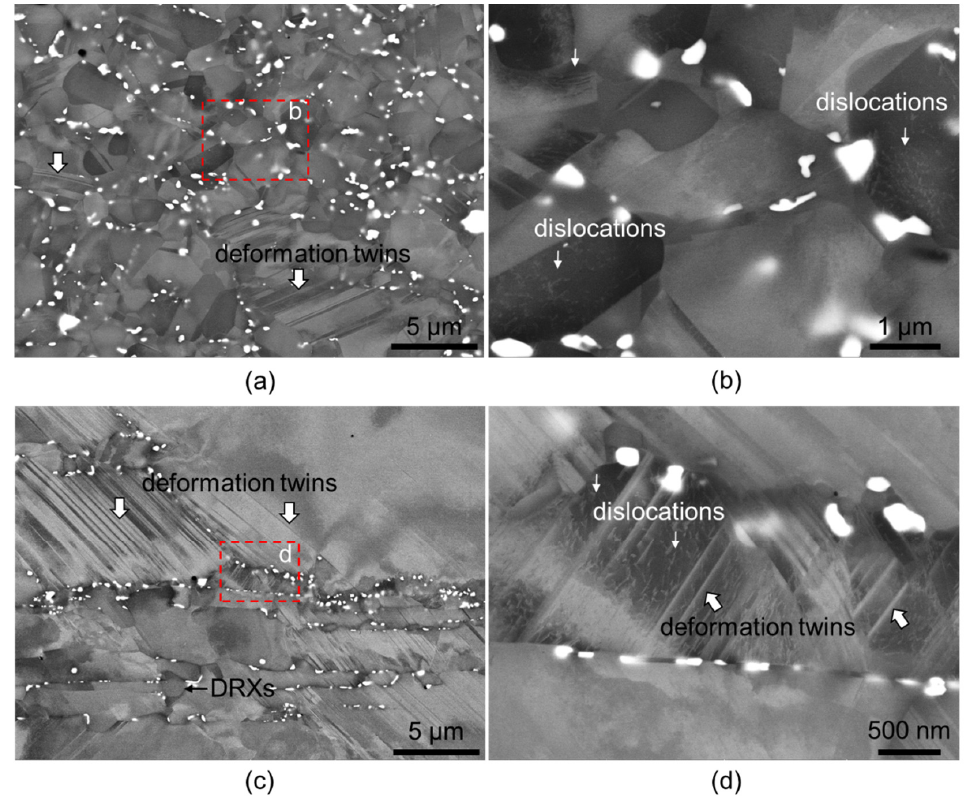
Figure 5. ECC images showing the substructures of the deformed samples: ( a , b ) FG and ( c , d ) CG.